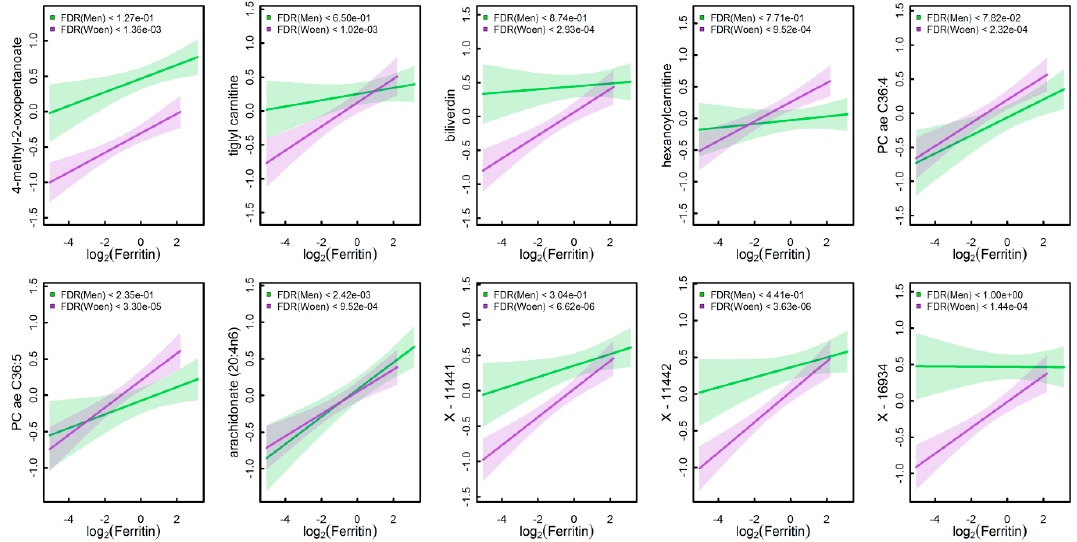
Figure 2. Predicted means and 95%-confidence interval of metabolites levels along serum ferritin concentrations based on linear regression models as outlined in the main text. Effect-estimates were separated by sex (men—green, women—purple). p -values after correcting for multiple testing, controlling the false discovery rate at (FDR) 5%, are given in the legend. Metabolite levels are given on a standardized scale where zero represents the population average and one refers to a shift of one standard deviation.